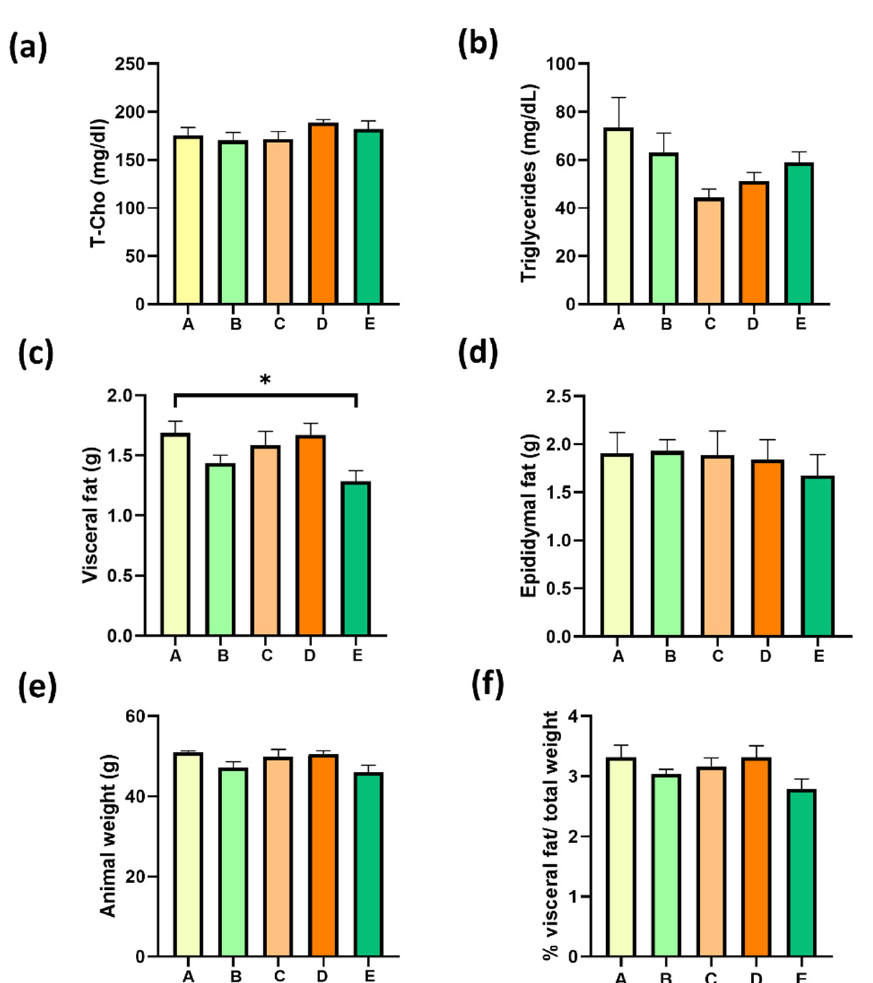
Figure 7. Serum lipid profile and adipose tissue weight of mice treated with a high-fat diet (HFD)-supplemented treatment. ( a ) total cholesterol; ( b ) triglycerides; ( c ) visceral fat; ( d ) epididymal fat; ( e ) animal weight; ( f ) % visceral fat/total weight. Treatments were as follows: Group A, sunflower oil; group B, gallic acid; group C, DRCSO; group D, sAG and group E, sPAG. Mice were fasted for 6 h before euthanasia (n = 6–8). Data are expressed as mean ± standard error of the mean (S.E.M.). Statistical differences were determined using one-way ANOVA, followed by Tukey’s post hoc test: * p < 0.05 .